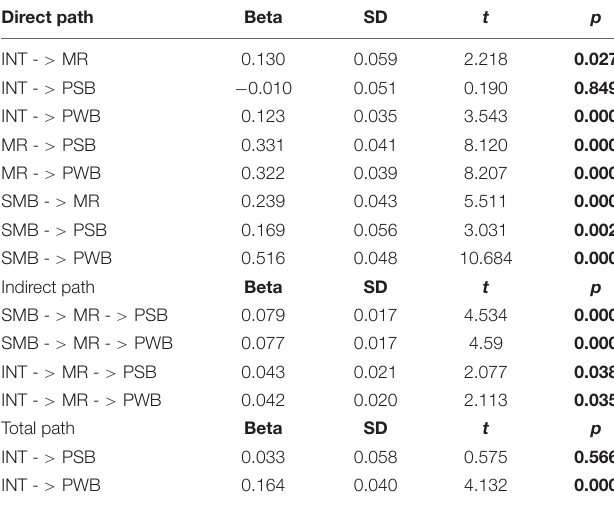
TABLE 4 | Direct, indirect and total path